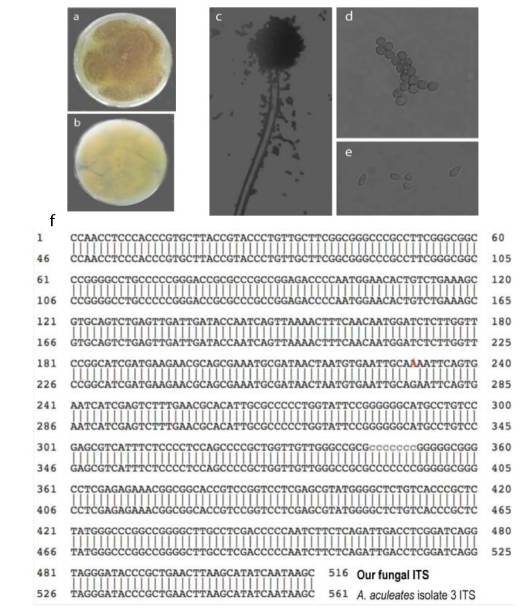
Figure 1. The candidate fungal extract (GFEL-46E5) significantly inhibited Plasmodium falciparum infection in mosquito midguts. ( a ) In the control group, a mosquito midgut was infected with P. falciparum . Each red dot represents one oocyst. ( b ) A mosquito midgut from GFEL-46E5 treated group did not possess P. falciparum oocysts. ( c ) Mosquitoes fed with P. falciparum containing GFEL-46E5 extract or dimethyl sulfoxide (DMSO, control) showed di ff erent numbers of oocysts. Each spot represents the number of oocysts in a mosquito midgut. The di ff erence between the two groups was significant (p < 0.001). N: # of mosquitoes for each treatment; µ : the mean oocysts per midgut; PR: infection prevalence in mosquitoes. The assays were repeated independently three times.